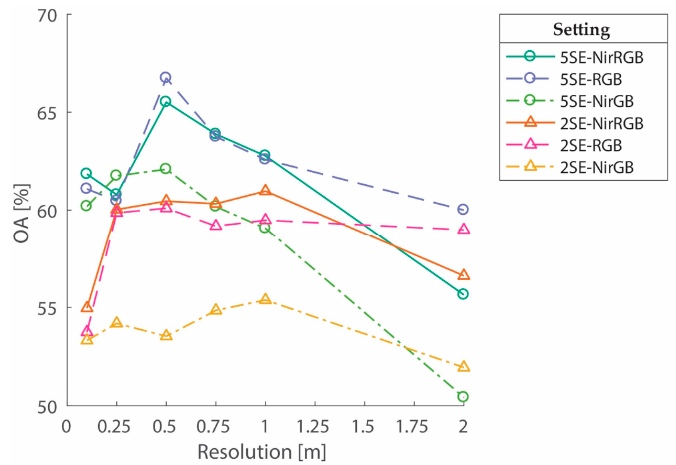
Figure 4. Overall accuracy (OA) for the full set of crop classes for all tested spatial resolutions and settings of the dataset for a pixel-based classification. Circles mark five structuring element (SE) sizes at evaluated resolutions and triangles two SEs, respectively. The line styles correspond to the applied spectral band selection.